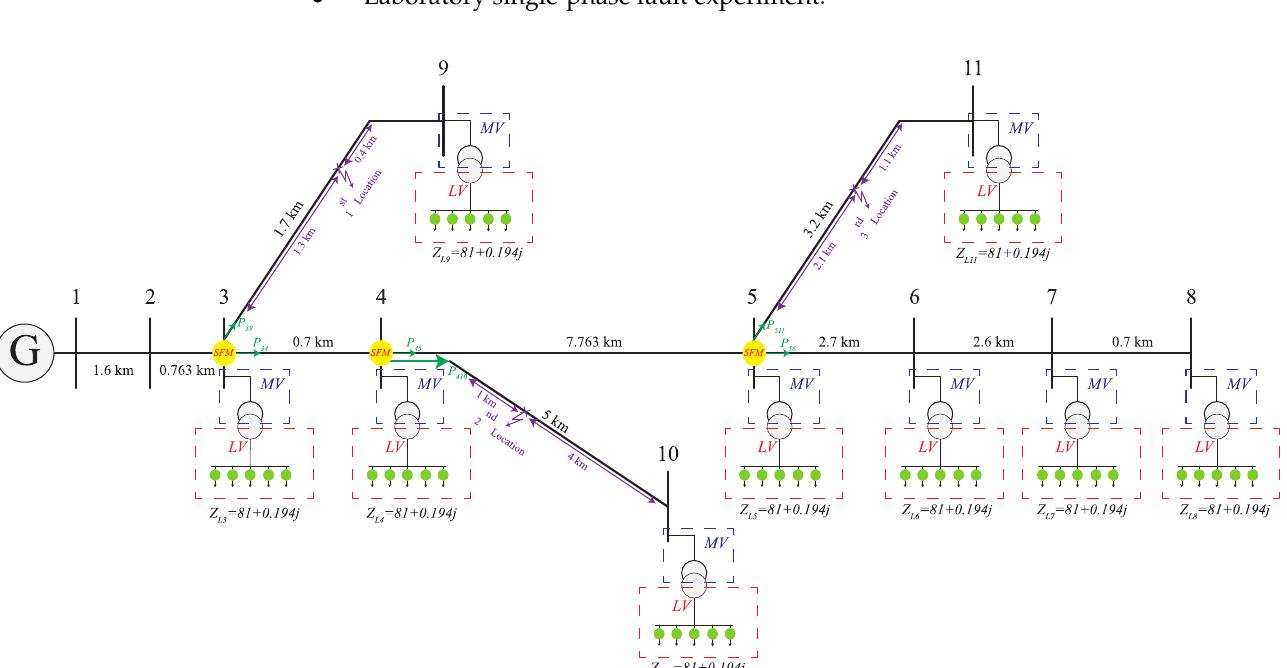
Figure 5. Single line diagram of IEEE 11-node test feeder equipped with smart meters and SFMs.